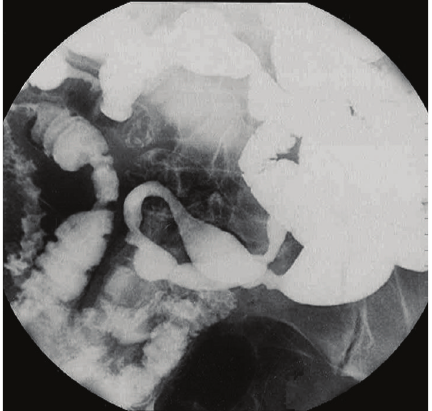
Figure 6: Enteroclysis. Multiple persisting stenoses of the small intestine caused by fibrous strictures. Courtesy of Zden˘ek